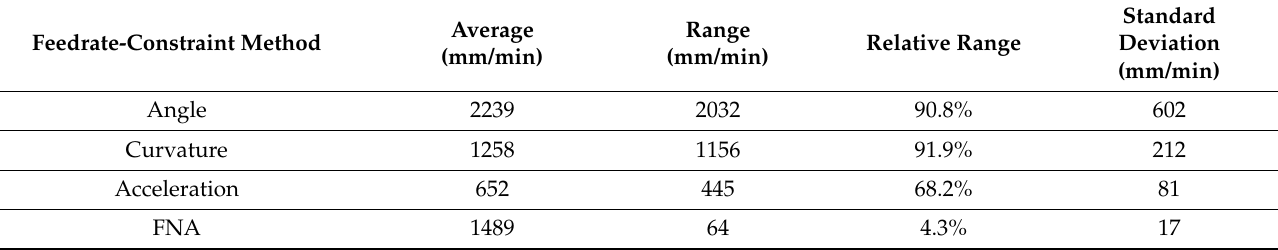
Table 3. The statistics results of the feedrate of each row when X = 43 mm.